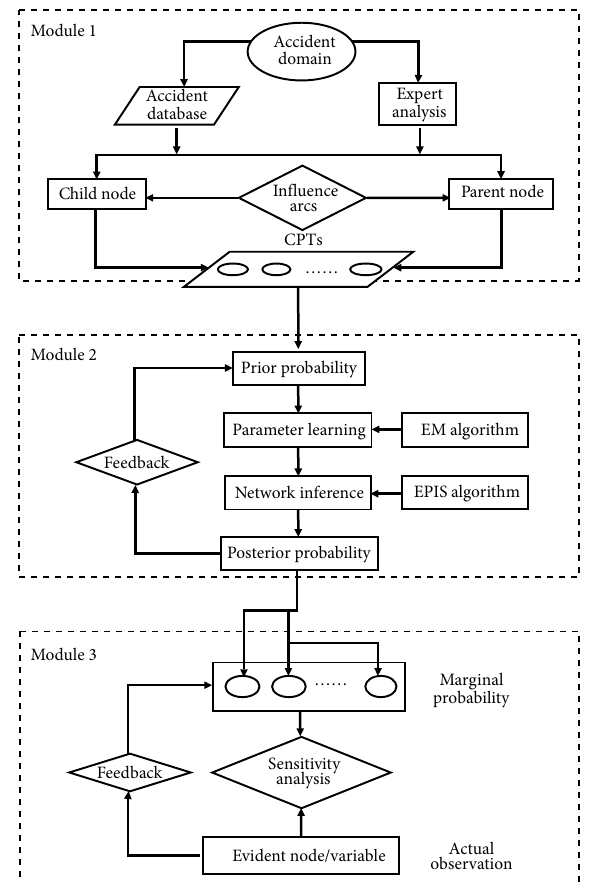
Fig. 2. Flow chart of BN risk analysis